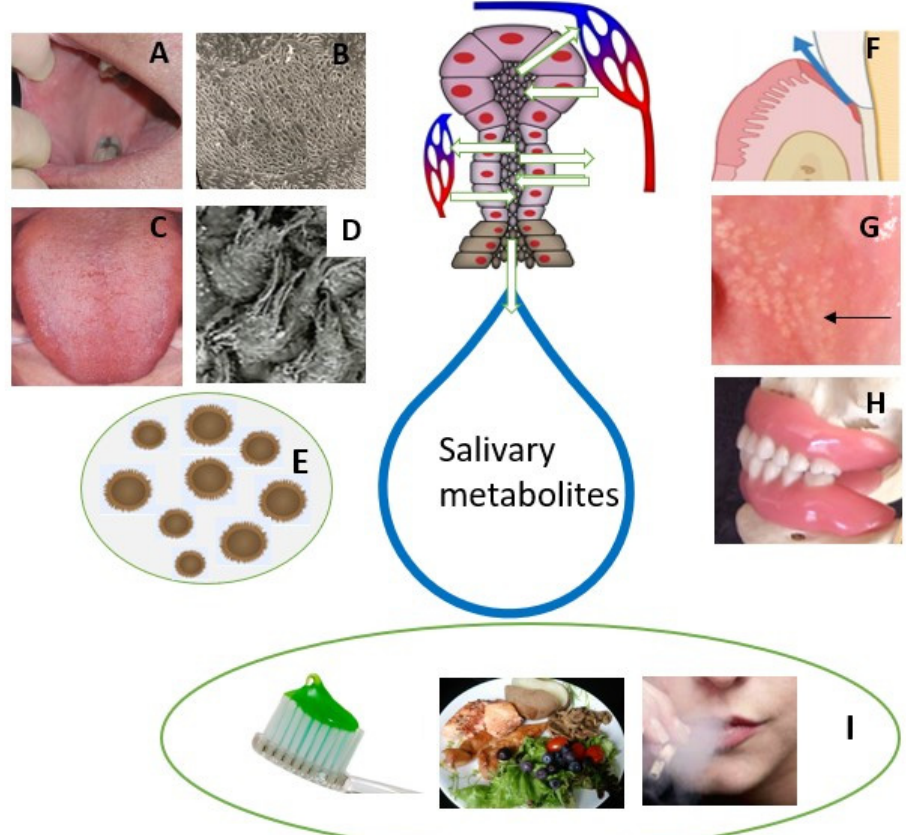
Figure 1. Summary of oral metabolite sources that may take part in salivary metabolic fingerprint in healthy subjects. Saliva is secreted by salivary glands in salivon with acinar and ductal cells. Metabolites are obtained also from oral mucosal cells ( A – D ) and gingival crevicular fluid ( F ). Most of salivary metabolites are produced by oral microorganisms ( E ). Sebaceous glands referred as Fordyce granules (arrow) are located in the buccal mucosa ( G ). Dentition and dentures ( H ) form different niches for attaching of microorganisms. Oral hygiene, diet, and habits, including smoking and alcohol consumption, differ salivary metabolite profile ( I ).